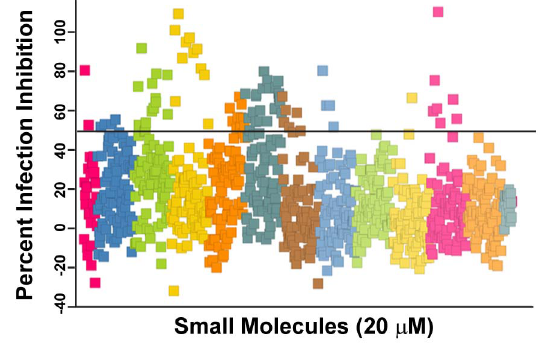
Figure 1. Assay development and validation of the HCI-based RVFV assay. ( A ) IFA of RVFV Gn expression (green) in RVFV-infected or mock-infected HeLa cells (cytoplasm is stained red). ( B ) Scatter plot distribution of percentage of cells expressing RVFV Gn acquired from mock-infected (green) or RVFV-infected (red) HeLa cells and the evaluation of degree of separation between the two controls (Z 9 - factor). Data are derived from triplicate experiments performed on three separate days. Horizontal line represents the average percent value of RVFV-infected cells.